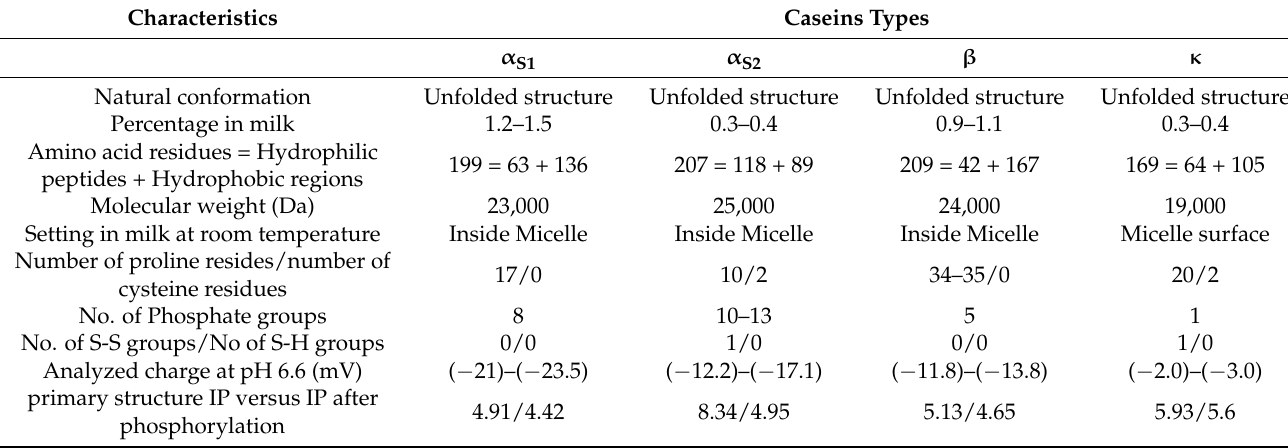
Table 1. Comparison of distinct properties of α S1 , α S2 , β and κ